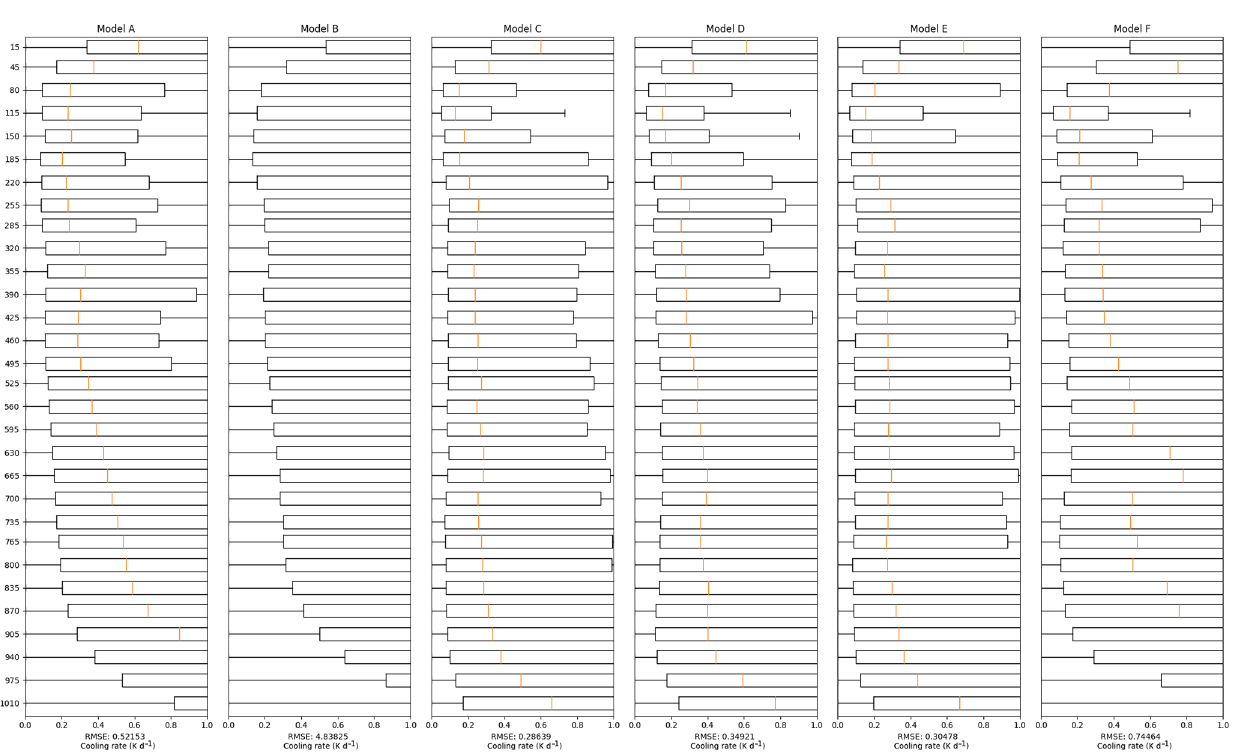
Figure 4. Models are trained with Dataset 1 and evaluated against Dataset 2 .